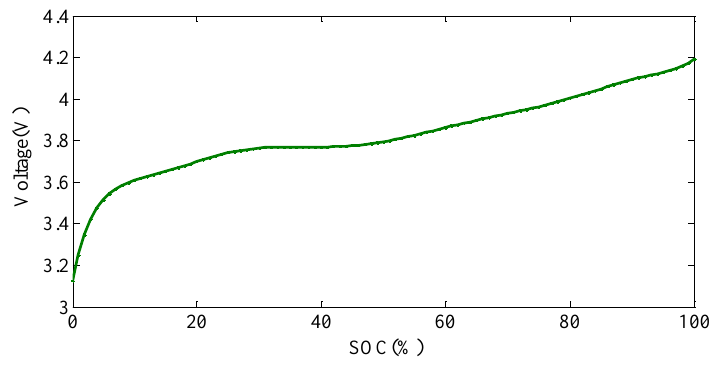
Figure 4. The OCV–SOC curve at 25 ◦